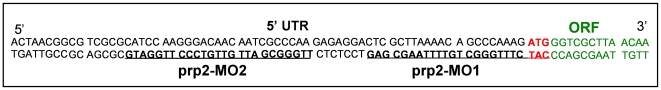
Morpholino sequences.Morpholino sequences (prp2-MO1and prp2-MO2 sequences underlined) used for knockdown of the zebrafish PrP2 gene function.